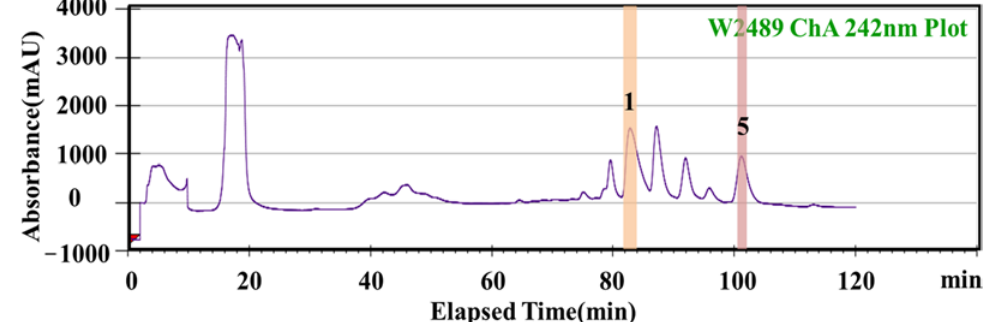
Figure 5. Semi − preparative high performance liquid chromatography (Semi − preparative HPLC) of P.cocos extract. (mobile phase acetonitrile (solvent A) and H 2 O (solvent C). Solvent gradient: 10% A, 0~5 min; 10~100% A, 5~60 min; 100% A, 60~150 min.; flow rate: 1.0 mL/min. Injection volume: 5.0 mL; detection wavelength: 270 nm. Compounds: (1) Tumulosic acid; (5) Dehydrotrametenolic acid.